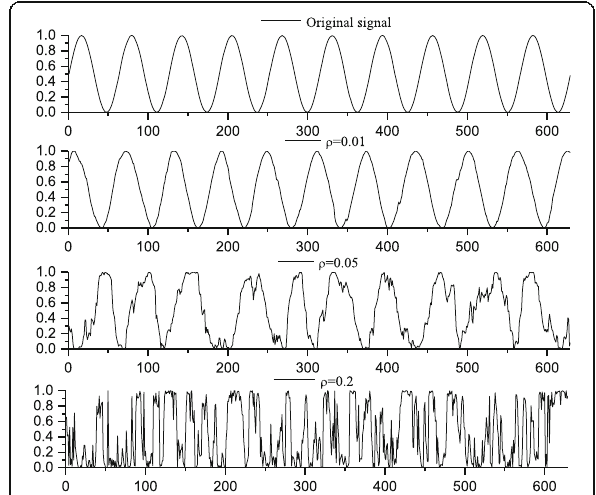
Fig. 2 Sine signal and the surrogate data under different noise intensity. Add noise of different intensities (corresponding to the value of parameter ρ ) to a sine signal using the PPS algorithm. With the increase of noise, the structure of source signal is gradually